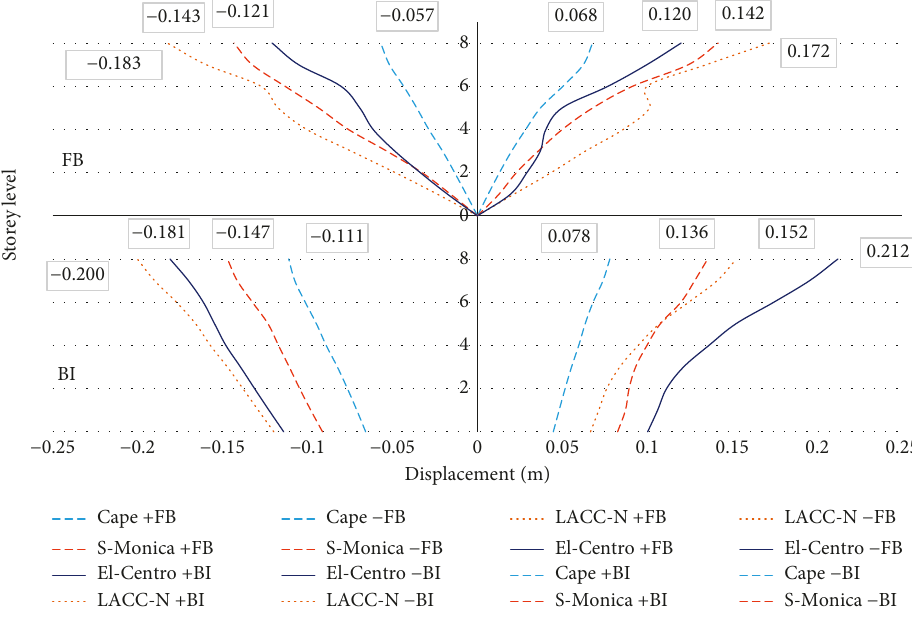
Figure 7: Envelope displacements of the taller buildings in different floors under seismic loads.